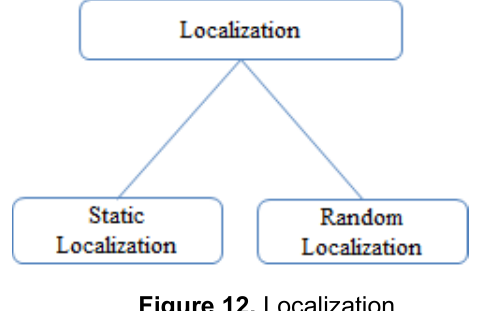
Figure 12. Localization